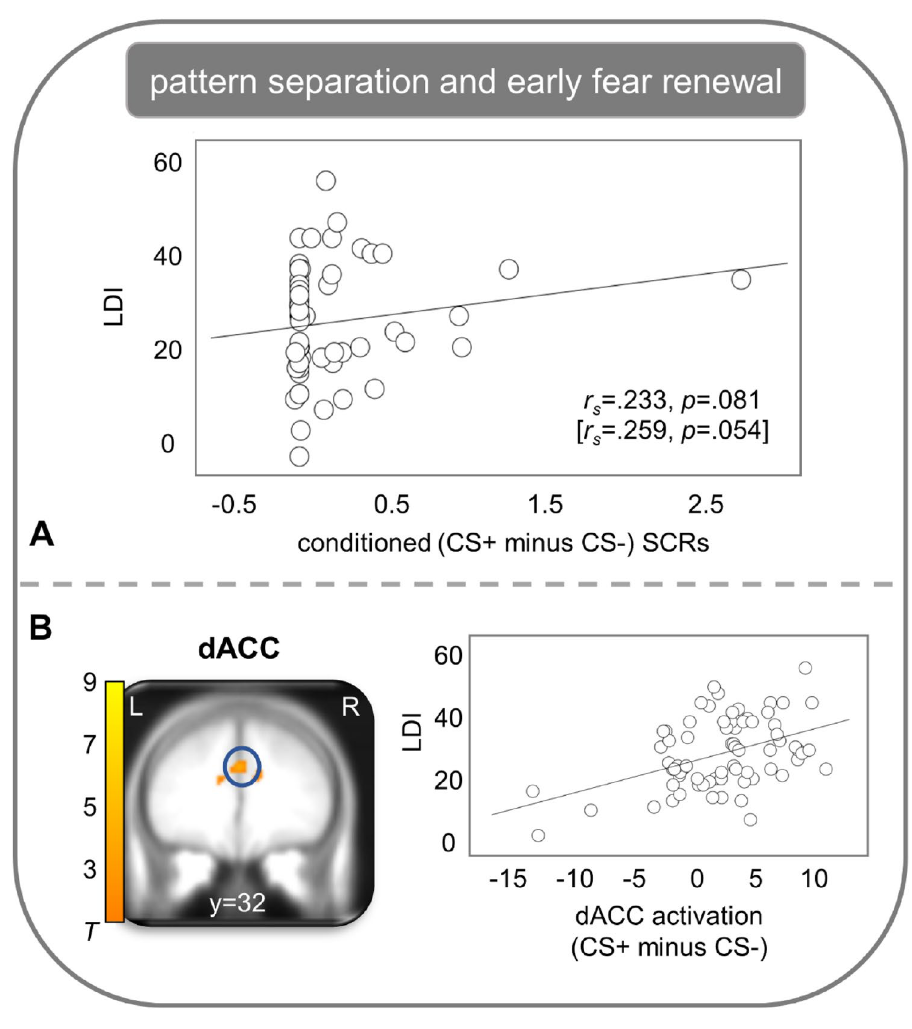
Figure 1. Association between pattern separation performance (LDI: Lure discrimination index) of the Mnemonic Similarity Task for objects and ( A ) conditioned (CS + minus CS −) skin conductance responses (SCRs) using Spearman’s rho correlation coefficient ( r s ) as well as ( B ) neural activation (CS + minus CS −) in the dorsal anterior cingulate cortex (dACC; contrast estimates of peak voxels) during early fear renewal in context C. Results of the control analyses (controlled for visuo-spatial working memory (sum scores of digit span of the Block-Tapping-Test)) are presented in square brackets. Neural activations were superimposed on the MNI305 T1 template. All coordinates (x, y, z) are given in MNI space. The color bar depicts T values. L: left, R: